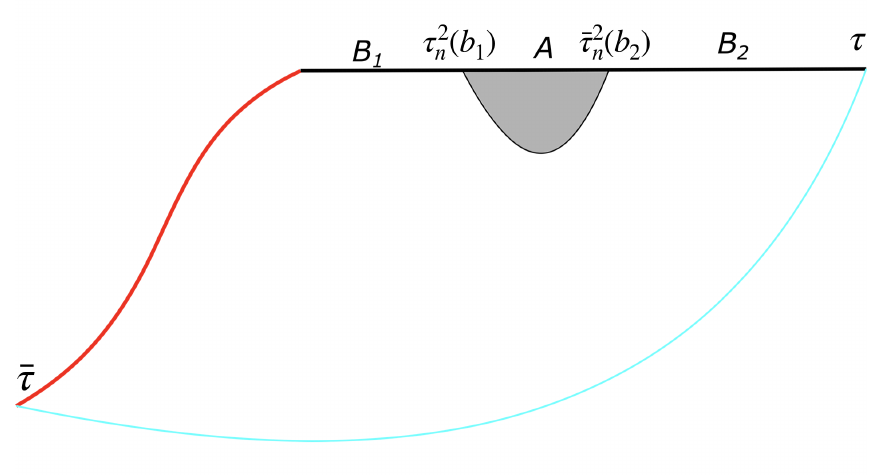
Figure 19: Schematic of the island proposal-II for the entanglement negativity of a single interval in